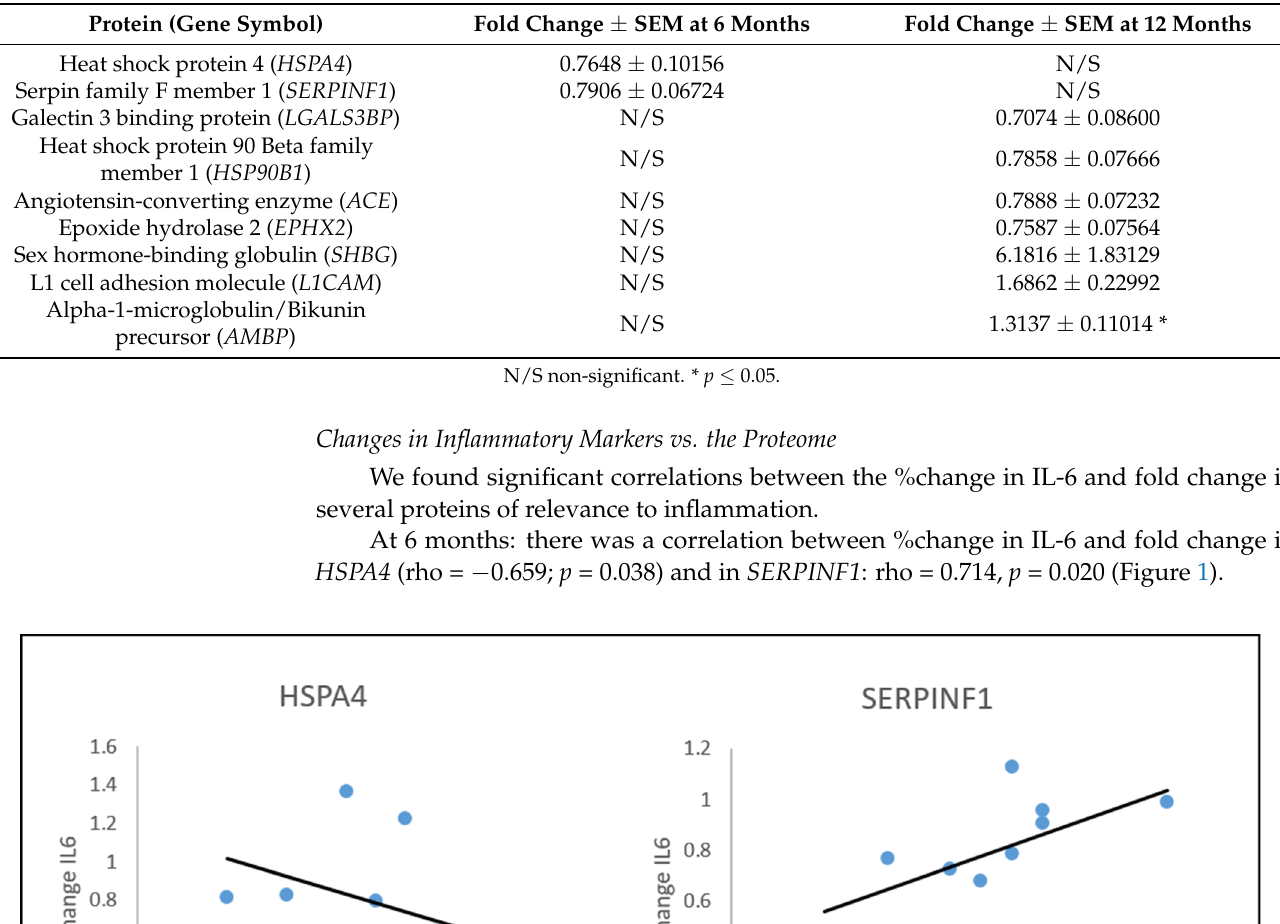
Table 2. Fold change in relevant proteins that showed correlations with inflammatory markers at 6 or 12 months post- surgery.